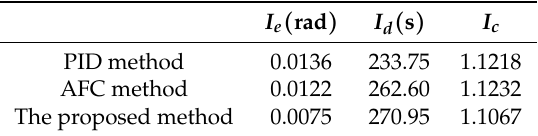
Table 2. Comparisons of quantitative evaluation indexes of the three methods.